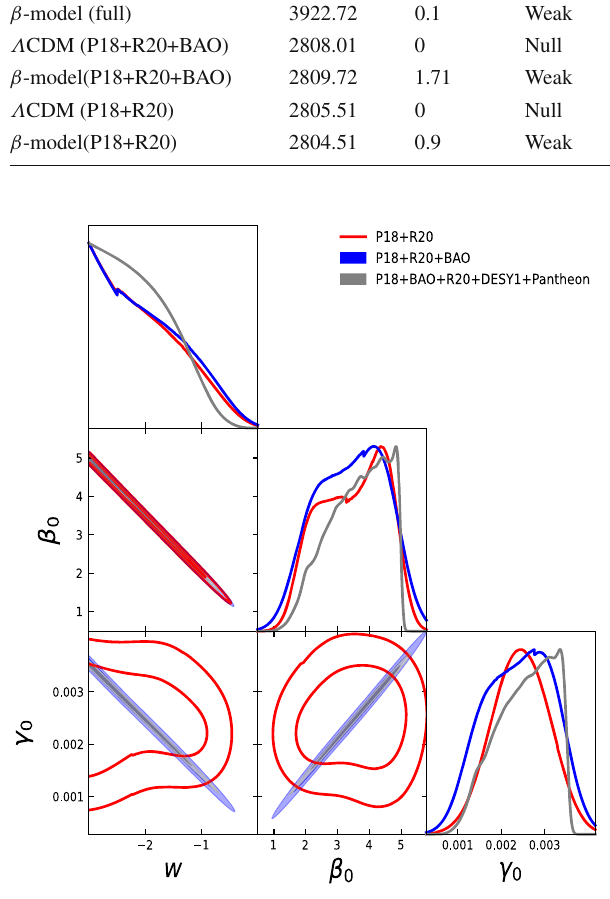
Fig. 3 Red,blueandgreycoloursindicatetheresultingcontoursforthe β γ w parameters at 68 . 4% and 95 . 7% C.L. of P18+R20+BAO, 0 , 0 and P18+R20+BAO+DESY1+Pantheon joint data, respectively. (For inter- pretation of the references to colour in this figure legend, the reader is referred to the web version of this